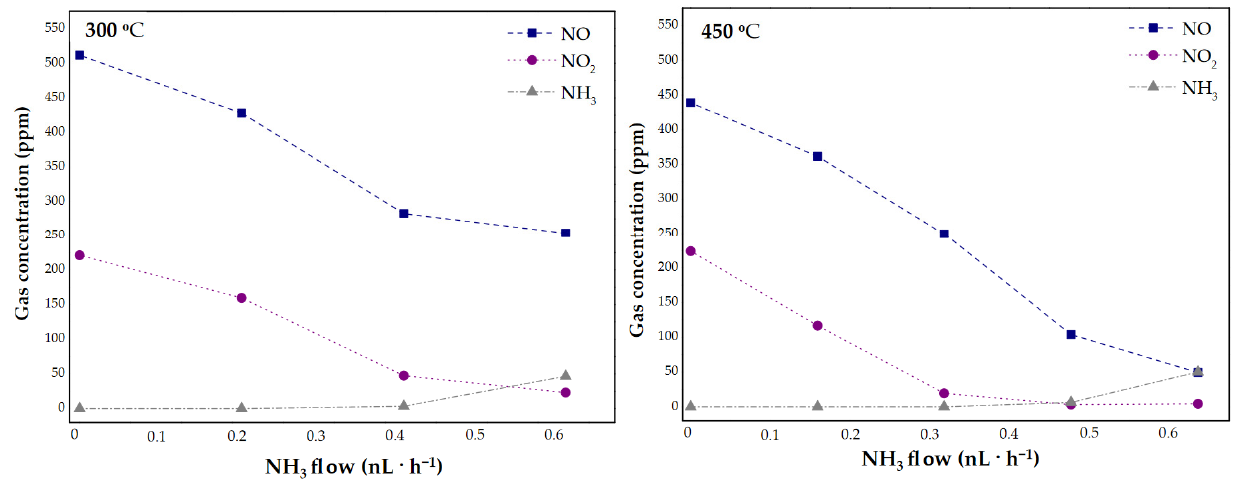
Figure 7. NO, NO 2 , and NH 3 concentration as a function of NH 3 concentration at 300 °C or 450 °C for the Fe-Clin-I at GHSV = 26,500 h − 1 .